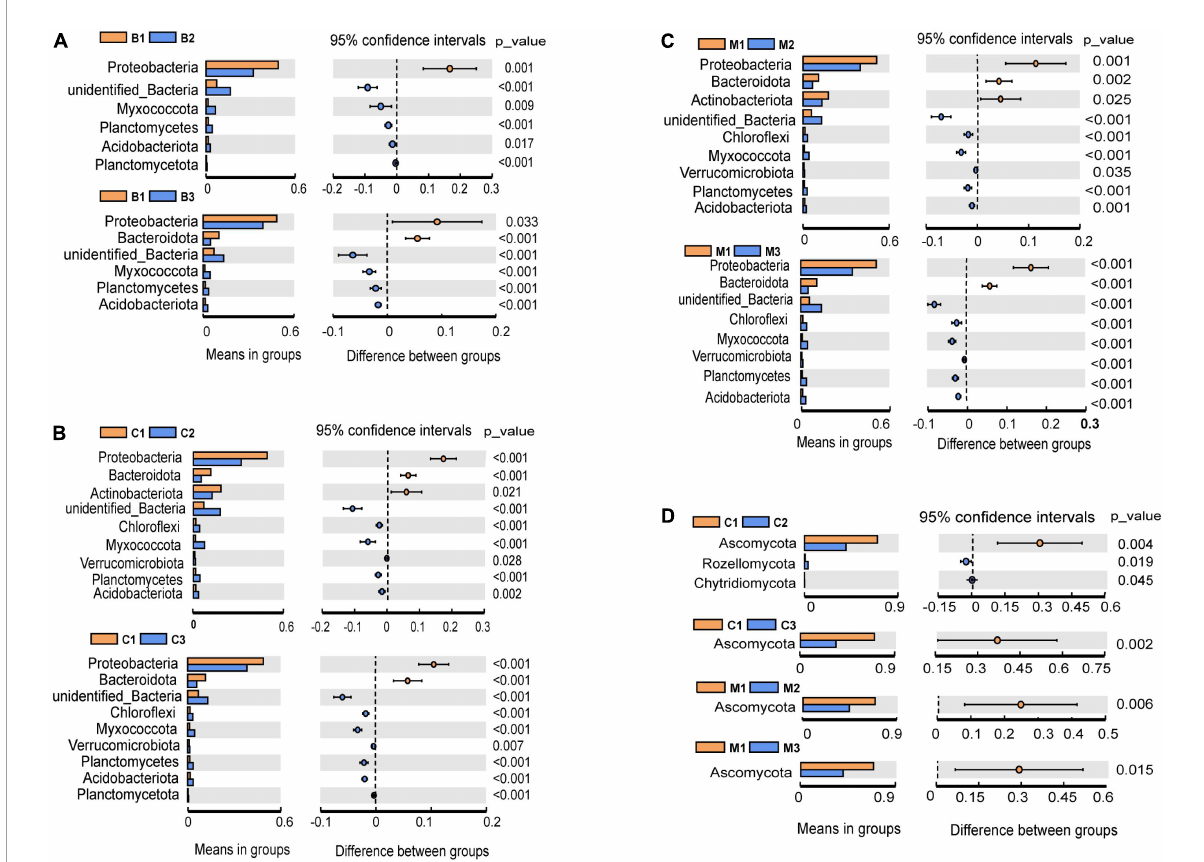
FIGURE3 Differential abundance analysis and comparisons with t -test at the phylum level during incubation. (A–C) Bacteria; (D) fungi. Only significant results ( p < 0.05) are shown. The letters in group ID represents nest material composition (B, bamboo leaf; C, couch grass; M, mixed litter; CG, control group); Arabic numerals represent different incubation periods (1, pre-incubation period; 2, mid-incubation period; 3, post-incubation